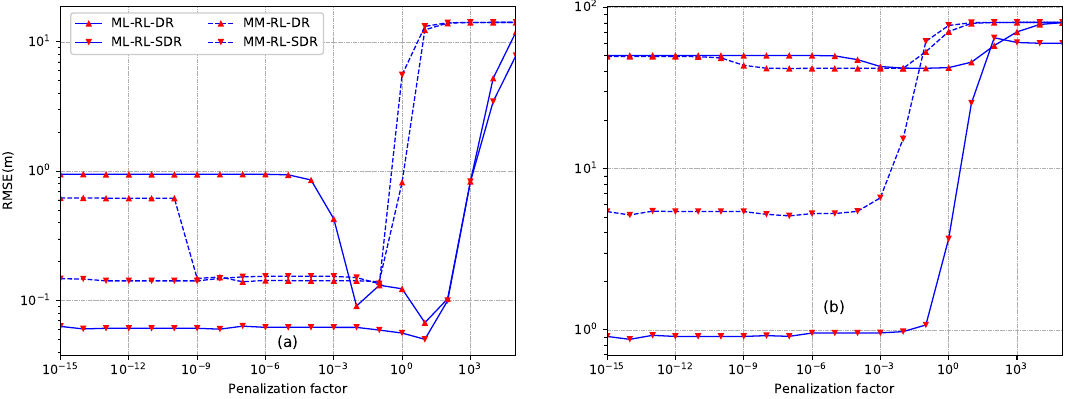
Figure 8. Comparison of the proposed source localization methods with different penalization factors. ( a ) the source is inside the convex hull of the sensor nodes ( y = [ 10,10 ] T ); ( b ) the source is outside the convex hull of the sensor nodes ( y = [ 10,80 ] T